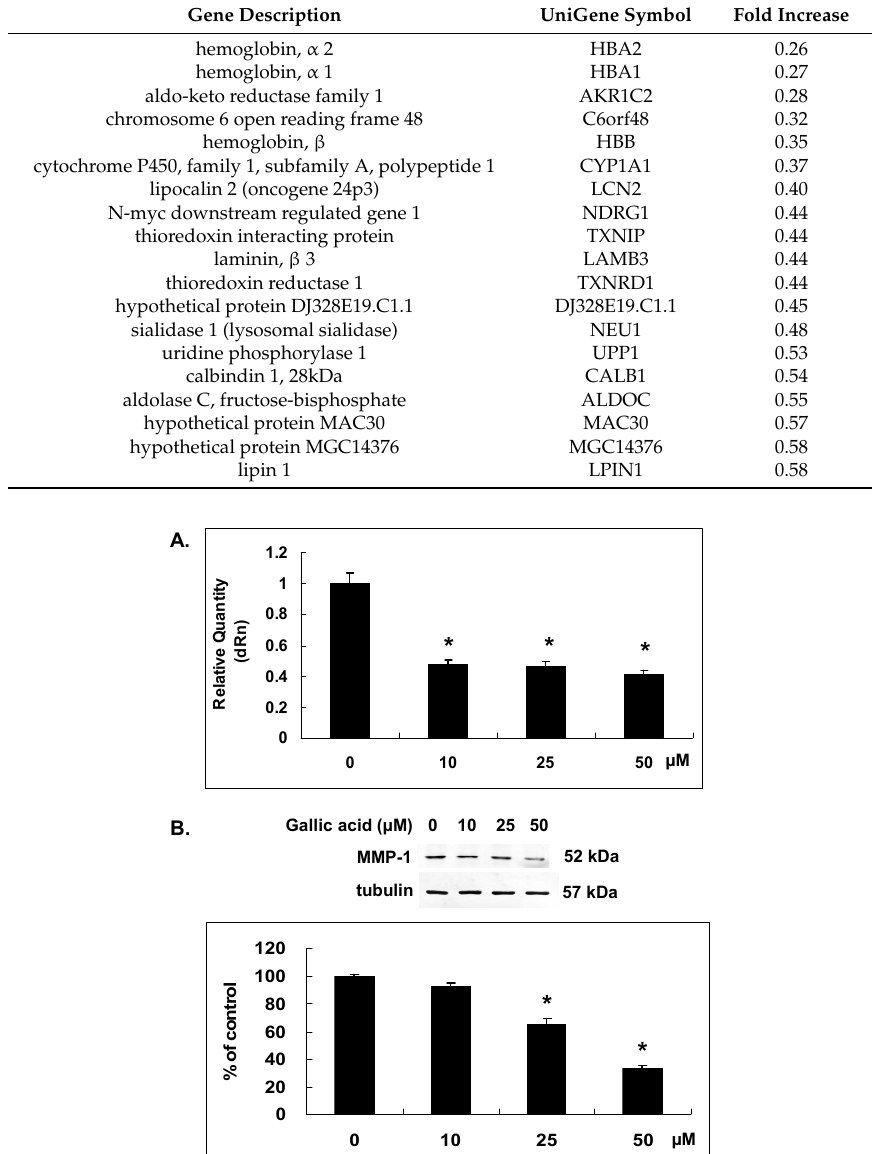
Figure 2. Gallic acid reduced matrix metalloproteinase-1 (MMP-1) expression . NPC-BM1 cells were treated with gallic acid for 24 h and the expressions of MMP-1 related to the mRNA ( A ); protein in cytosol ( B ) and conditioned medium; ( C ) were measured by qRT–PCR, Western blot and ELISA analysis respectively. The gallic acid dose-dependently decreased MMP-1 gene and protein expressions in NPC-BM1 cells. Delta Rn (dRn) indicated the magnitude of fluorescence signal generated during the PCR at each time point. Data were representative results from experiments repeated at least three times. * p < 0.05 versus vehicle control. 2.3. Gallic Acid Inhibited MMP-1 Promoter Activity The mRNA expression of MMP-1 gene is known to be regulated at the promoter region by transcription factors including AP-1 and Est-1. We have constructed the − 397 to +87 bp region of the MMP-1 promoter containing the AP-1 and Ets-1 binding motifs in pGL3 vector as shown in Figure 3A and dual luciferase assay was performed to measure the MMP-1 promoter activity in NPC-BM1 cells with or without treatment of gallic acid. Results demonstrated that gallic acid at 10, 25 and 50 µM could dose-dependently decrease the MMP-1 promoter activity in NPC-BM1 cells by approximate 20%, 40% and 70% ,respectively, in comparison with control level as shown in Figure 3B.